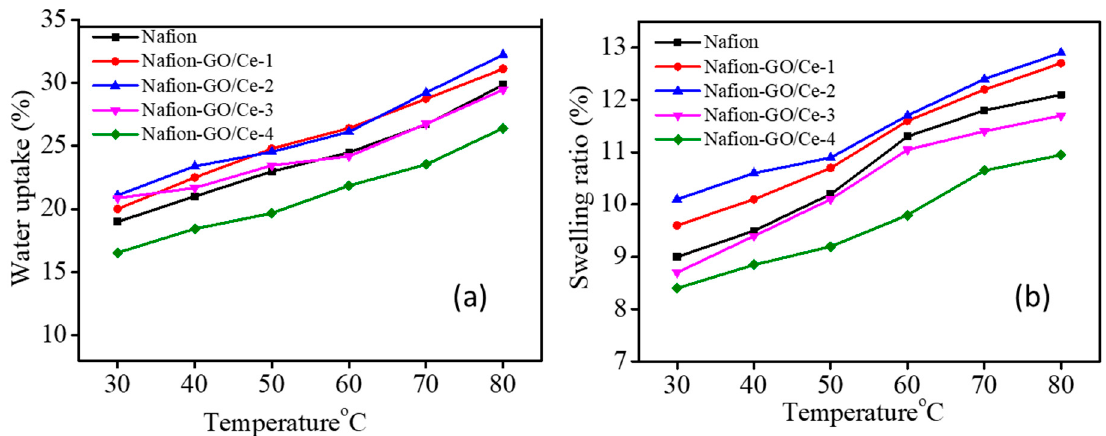
Figure 4. ( a ) Water uptake and ( b ) swelling ratio vs. temperature of different composite membranes. Table 1. Water uptake (WU), swelling ratio (SR), ion exchange capacity (IEC) and proton conductivity of different types of Nafion-GO/Ce